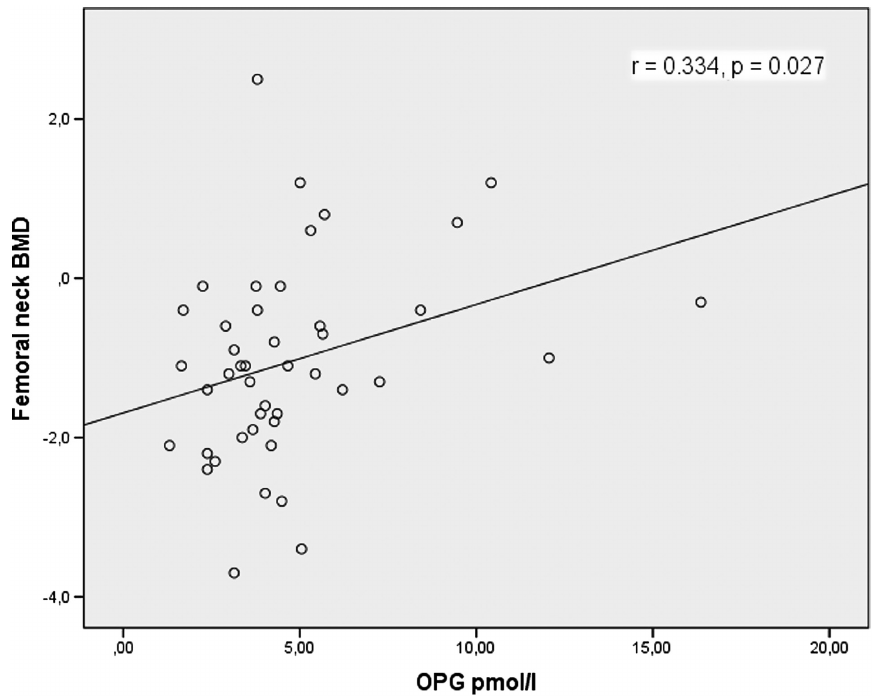
Figure 2. Correlation between femoral neck BMD and OPG in PHPT patients. BMD, bone mineral density; OPG, osteoprotegerin; PHPT, primary